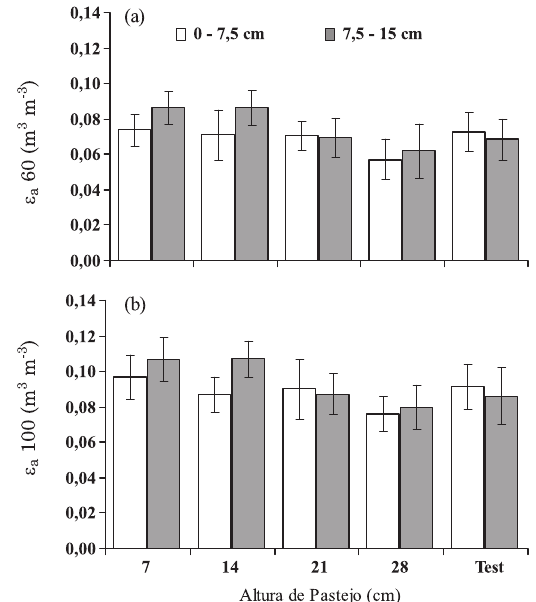
Figura 3. Porosidade com ar no potencial -6 kPa ( e a 60), nas camadas de 0–7,5 e 7,5–15 cm (a), e no potencial -10 kPa ( e a 100), nas camadas de 0–7,5 e 7,5–15 cm (b). As barras referem-se ao intervalo de confiança da média, e a sobreposi- ção dos intervalos de confiança indica ausência de diferenças entre as médias dos